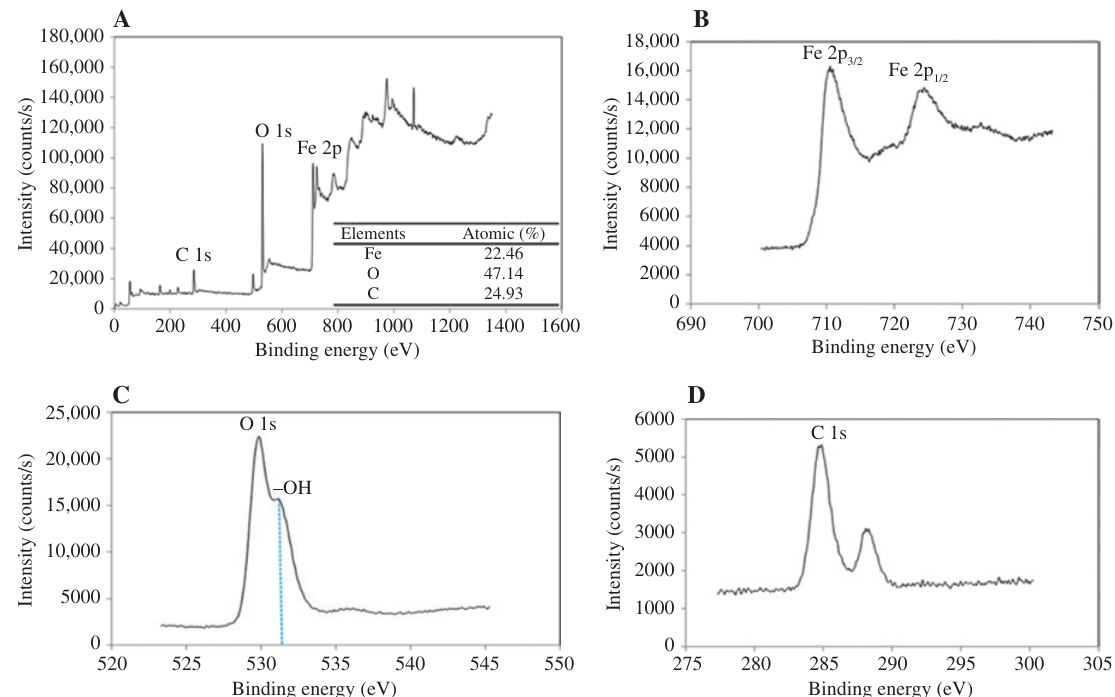
Figure 5: The X-ray photoelectron spectra (XPS) of (A) the phytogenic magnetic nanoparticles (PMNPs); (B) high-resolution X-ray photoelec- tron spectra (XPS) spectra of Fe 2p; (C) high-resolution XPS spectra of O 1s; (D) high-resolution XPS spectra of C